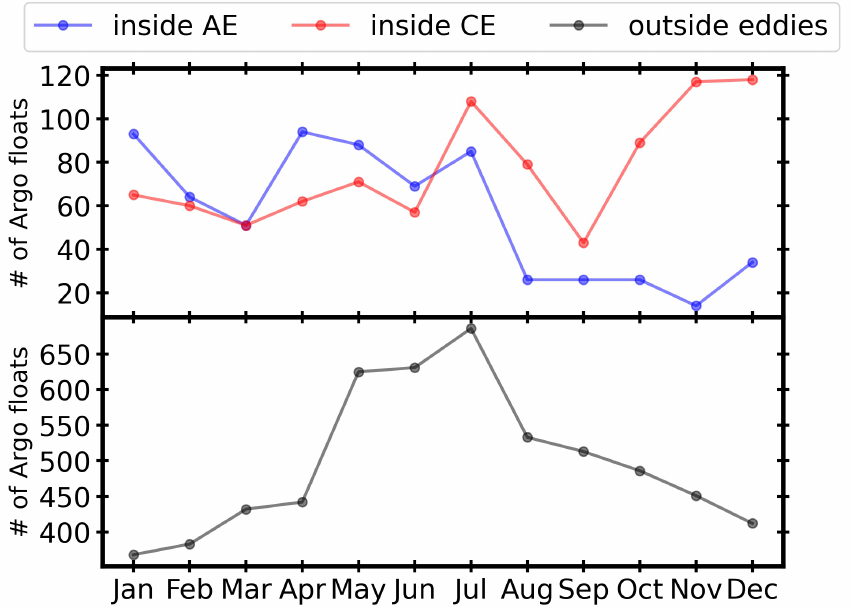
Figure 2. Average distribution of the ARGO float positions inside eddies (figure at the top) and average distribution of the ARGO float positions outside eddies (figure at the bottom) for the different months of the year. Regarding the top figure, there are two distinct censuses for the AC and for the AE. The number (#) in the y axis of this figure refers to the number of colocalized ARGO